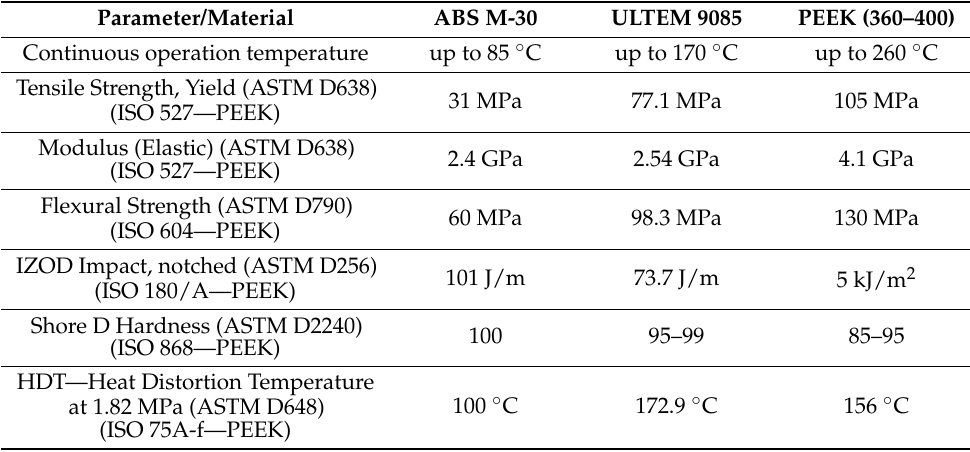
Table 2. Selected properties of materials used in 3D-printed gears [63–66].